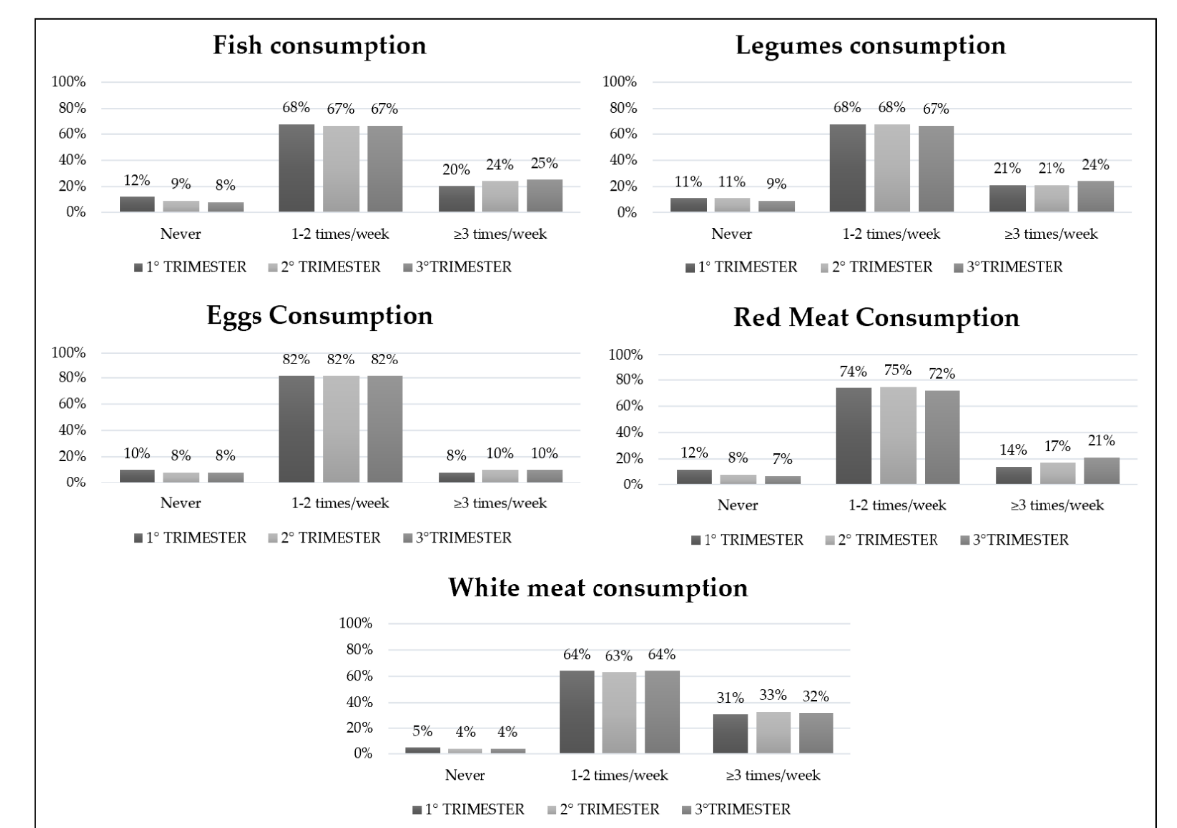
Figure 2. Animal and vegetable frequency intake during all pregnancy trimesters.